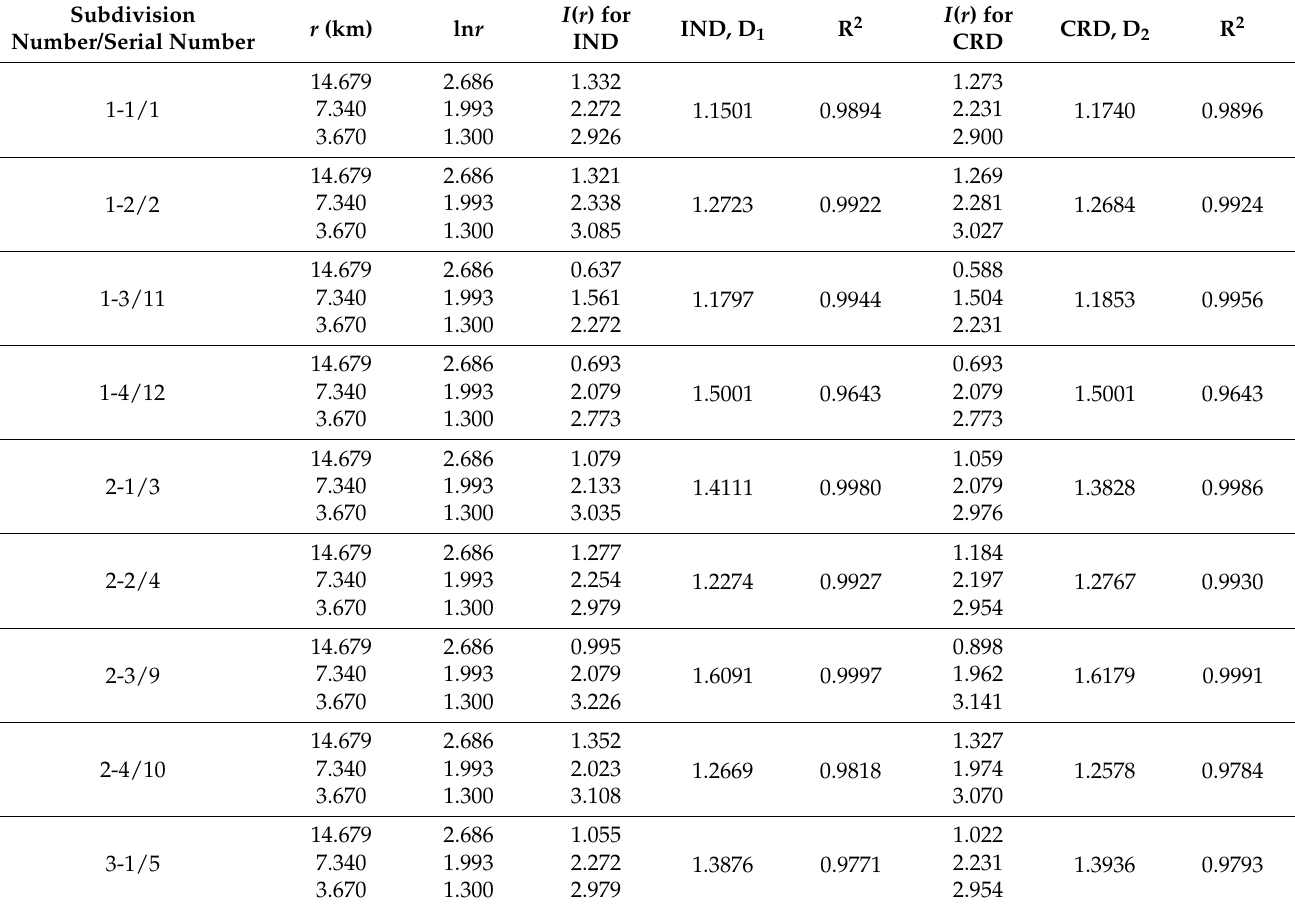
Table 7. Statistical table of calculation parameters for the information dimension (IND) and correlation dimension (CRD) of